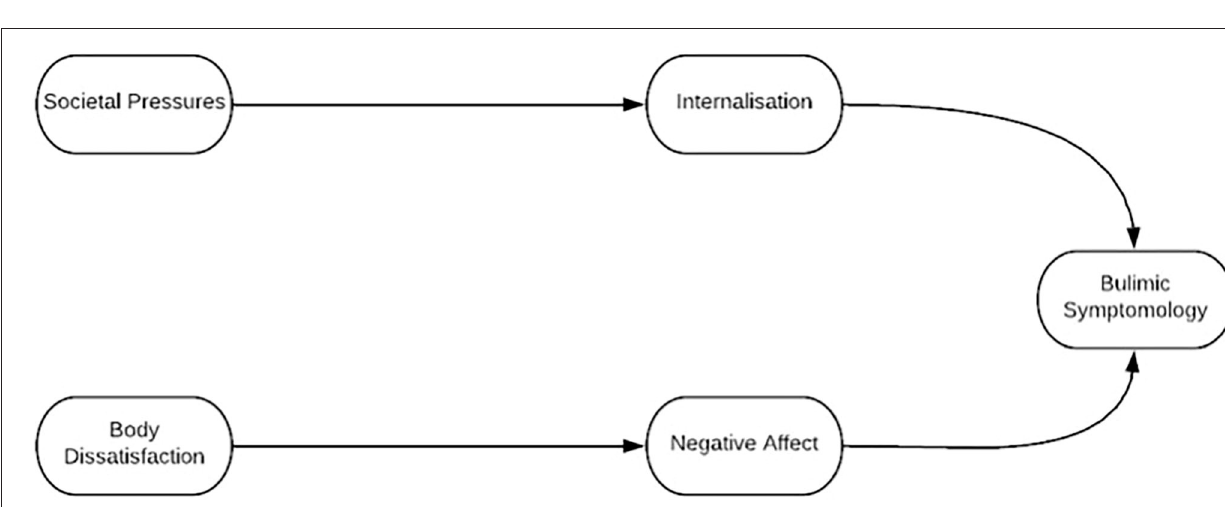
FIGURE 1 | Theoretical model of disordered eating development in athletes proposed by Petrie and Greenleaf (2007).